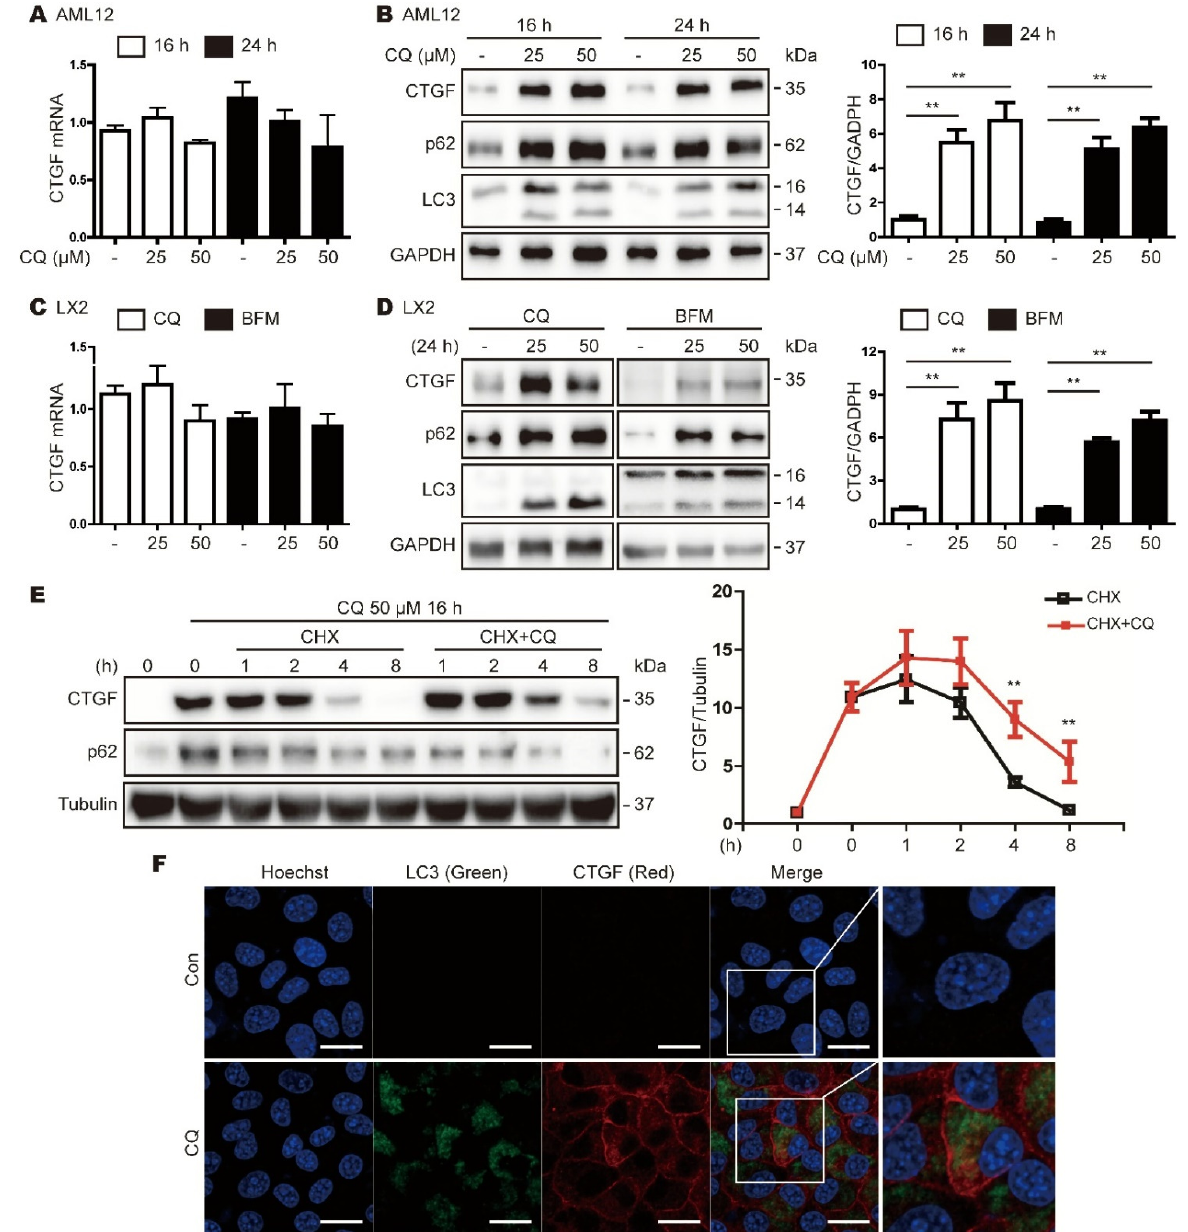
Figure 3. Autophagy inhibitors increase CTGF expression. ( A , B ) AML12 cells were treated with 25 or 50 µ M CQ for 16 or 24 h ( A ) Representative real-time RT-PCR analyses of CTGF mRNA expression in AML12 cells treated with or without CQ. The data represent the mean ± SEM (n = 3). ( B ) Western blot analyses showing the effects of CQ on CTGF expression in AML12 cells. The data in the bar graph are means ± SEM of three independent measurements. ** p < 0.01. ( C , D ) LX2 cells were treated with 25 or 50 µ M CQ for 24 h, or with 25 or 50 nM BFM for 24 h. ( C ) Representative real-time RT-PCR analyses of CTGF mRNA expression in LX2 cells. The data represent the mean ± SEM (N = 3). ( D ) Western blot analyses showing the effects of CQ or BFM on CTGF expression in LX2 cells. The data in the bar graph are means ± SEM of three independent measurements. ** p < 0.01. ( E ) Western blot analysis showing the effect of CQ on the stability of the CTGF protein in cells treated with cycloheximide (CHX) to inhibit protein synthesis. The cells were treated with or without CQ (50 µ M) for up to 16 h, and protein expression was determined at 1, 2, 4 and 8 h. Tubulin expression was measured as a loading control. The data in the graph represent the mean ± SEM. (n = 4); ** p < 0.01. ( F ) IF staining of CTGF (red) and LC3 (green) in AML12 cells treated with or without CQ for 24 h. Con,